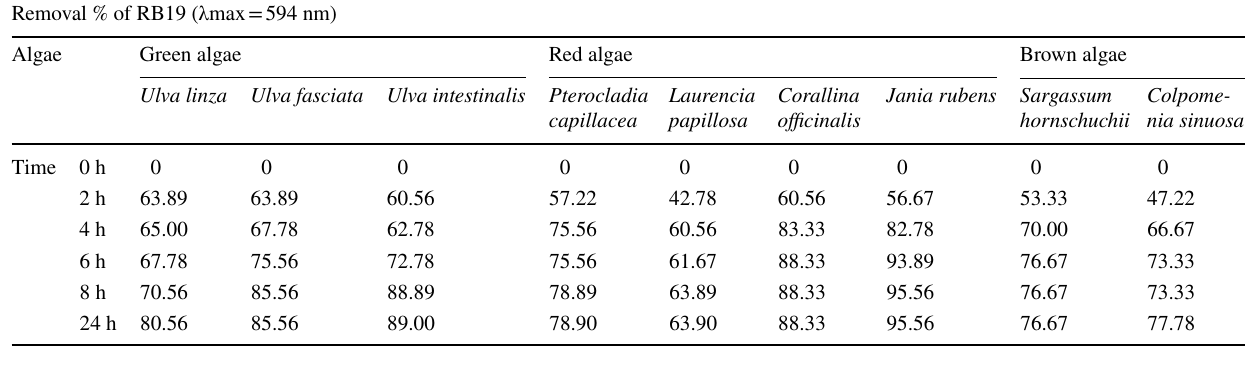
Fig. 1 Removal percentage of Reactive Blue 19 by the nine studied fresh algal species